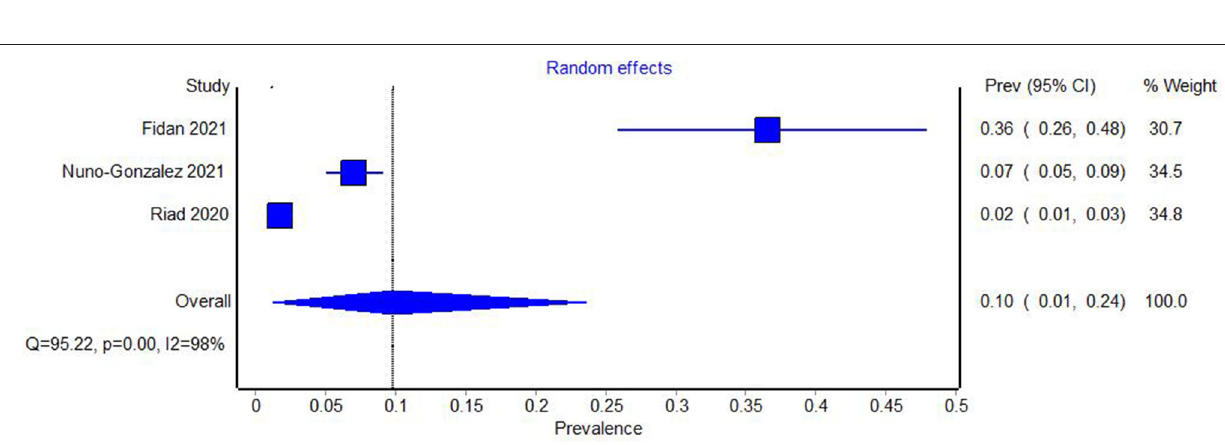
FIGURE 5 | Forest plot showing the pooled prevalence of aphthous oral lesions in COVID-19 with studies at high risk of bias excluded.